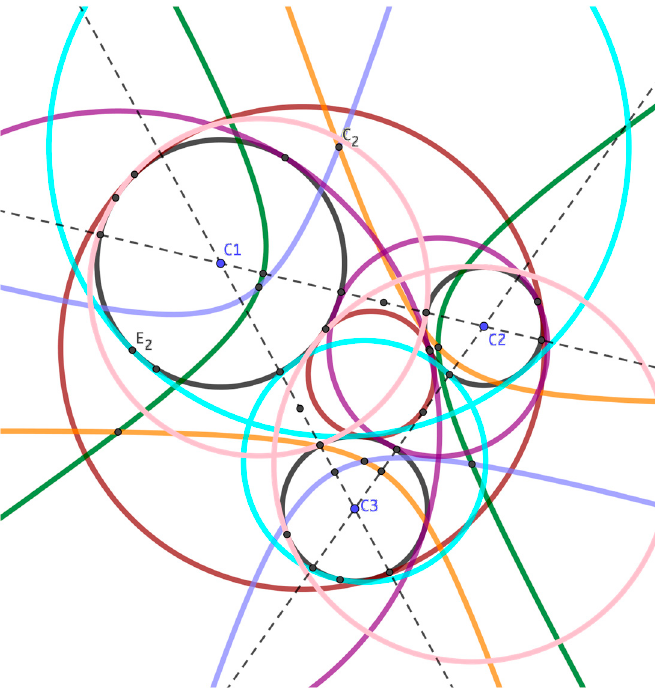
Figure 13 . Drawing eight tangent circles to three given circles Figure 13. Drawing eight tangent circles to three given circles (https://www.geogebra.org/m/vmd8 (https://www.geogebra.org/m/vmd8s4xs, accessed on 3 January 2021). s4xs, accessed on 3 January